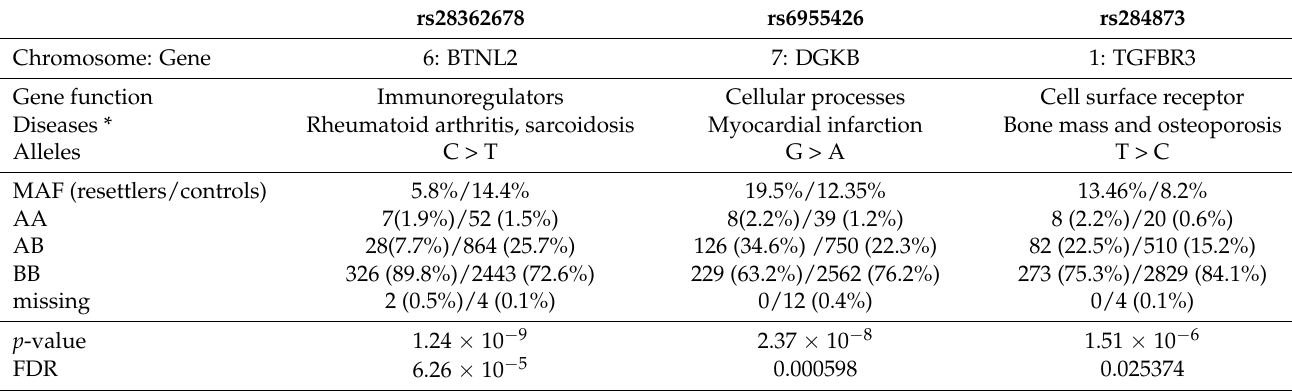
Table 3. SNPs differentiating resettlers and native Germans, and the distribution of the